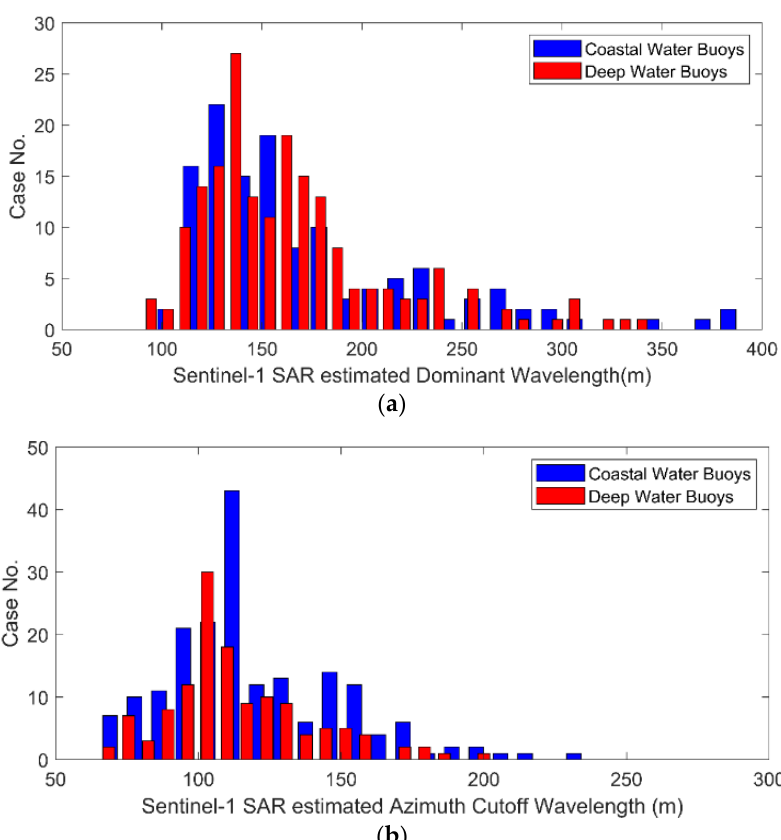
Figure 4. Estimated azimuth cut-off wavelengths ( a ) and dominant wavelengths ( b ) from both VV and VH polarization NRCS data versus those from VV polarization NRCS data alone.